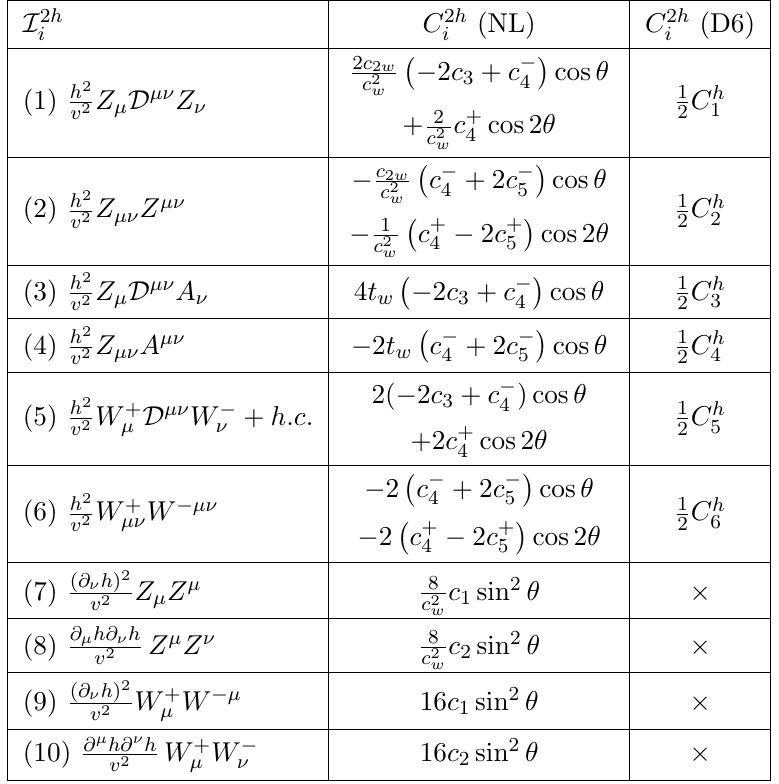
Table 2. The coupling coe(cid:14)cients C 2 h (NL) and the dimension-six case in SMEFT (D6). A cross ( the order we considered. Notice C 2 h